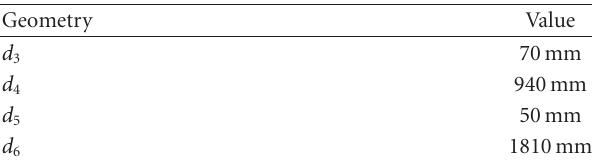
Table 2: Geometry of wooden base.